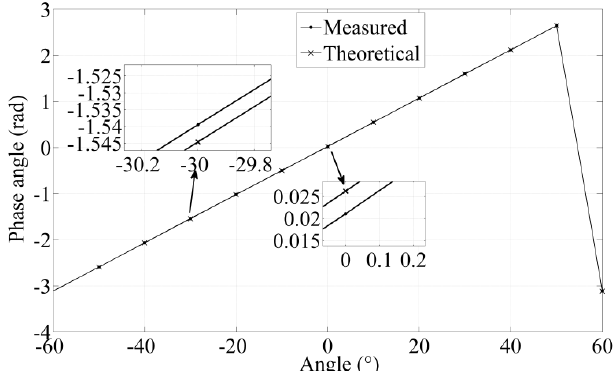
Figure 12. Error of the sensor prototype in phase